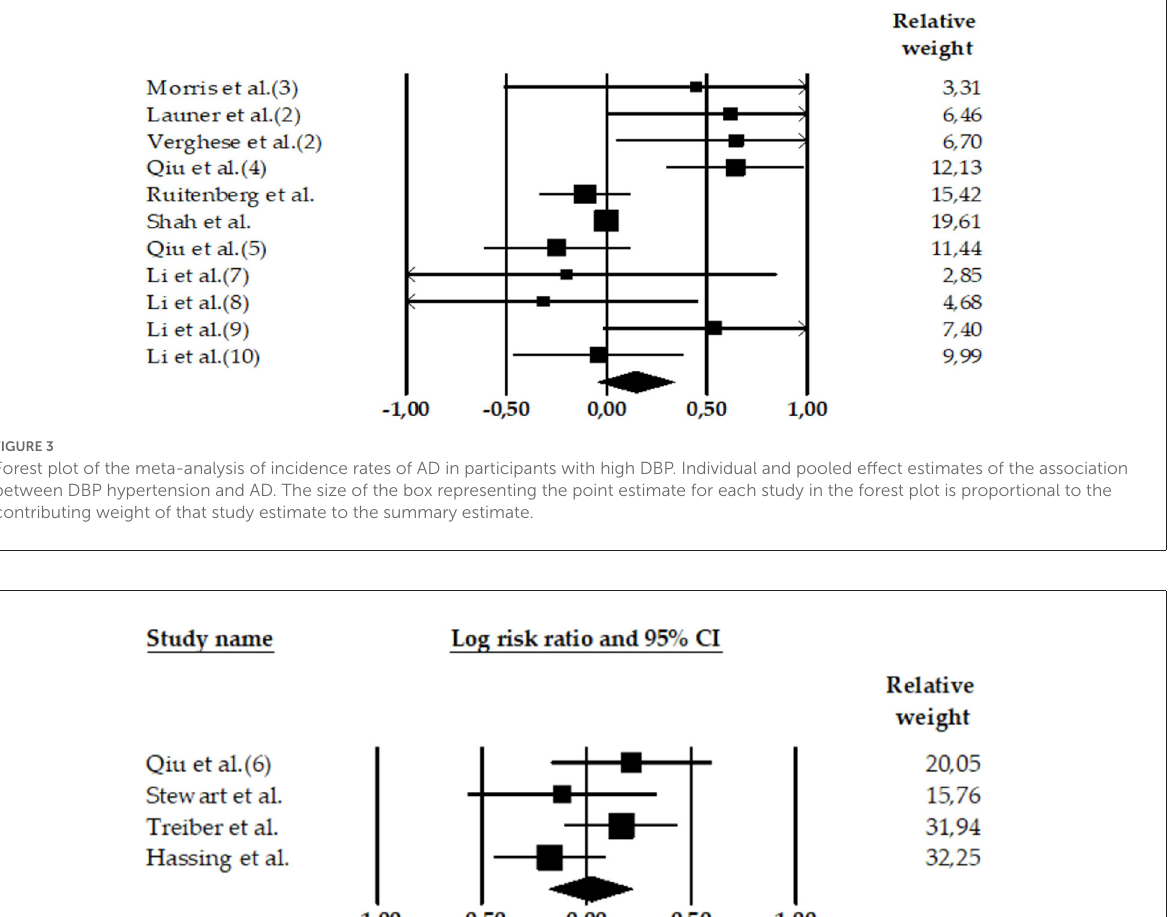
participants; nHC = 1,438,453 (LnRR = 0.09, 95%CI = 0.013– 0.166, Z = 2.28, p = 0.022) (see Table 2). The heterogeneity